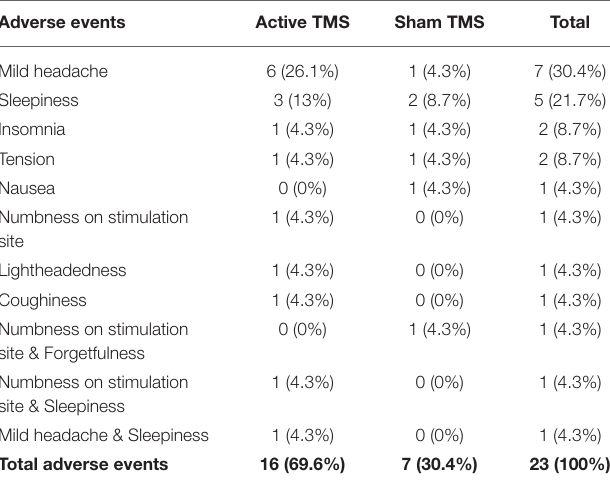
TABLE 5 | Adverse events of ( N = 23) participants, n (%). Adverse